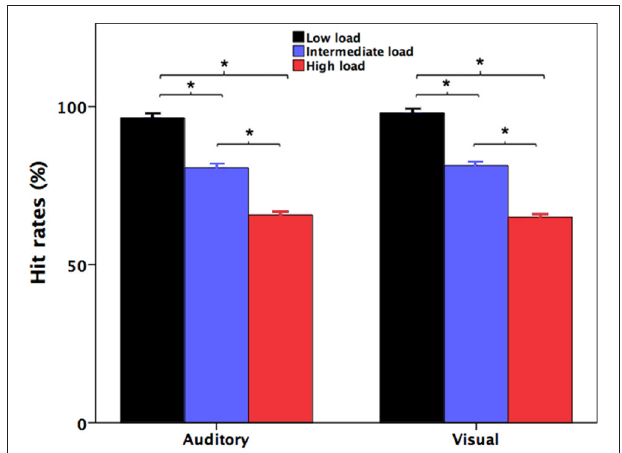
FIGURE 1 | Participants’ accuracy at recalling the number of the pitch perturbations (auditory) and the number of the red indicator light flashes (visual) during the low-load (black), intermediate-load (blue), and high-load (red) conditions of divided attention. The asterisks represent significant differences between the load